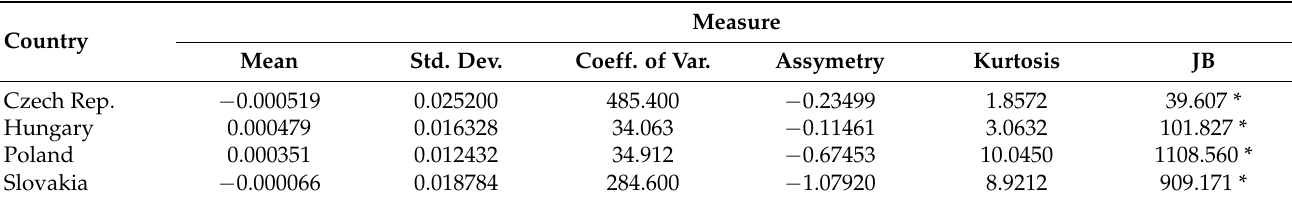
Table 1. Summary statistics for Pb95 gasoline weekly log-returns.